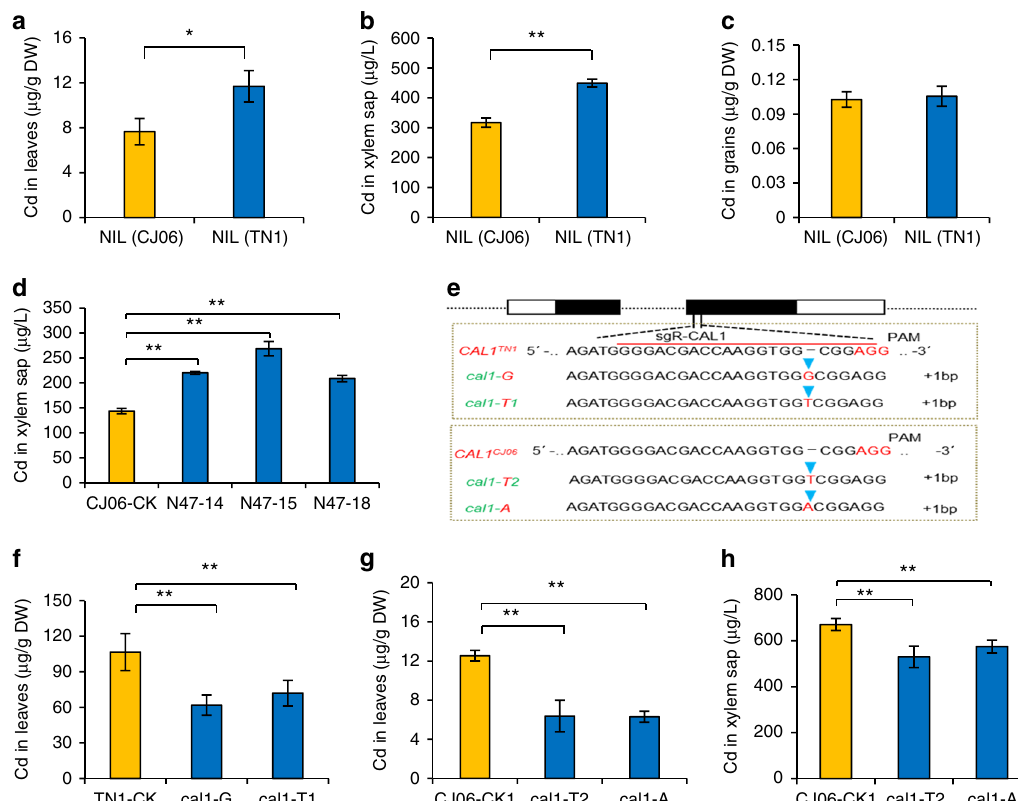
Fig. 2 CAL1 positively regulates Cd contents in rice leaf and xylem sap. Leaves and xylem sap were collected from 2 weeks old seedlings exposed to 10 µ M Cd for 7days, and grains was sampled from rice plants grown in Cd-contaminated paddy soil. a – c Cd levels in leaves ( a ), xylem sap ( b ) and grains ( c ) from NIL(TN1) and NIL(CJ06). d , e determination of Cd contents in xylem sap ( d ) of the CAL1 -complementation lines N47-14, N47-15, and N47-18, which simulate overexpression lines due to increased expression of CAL1 (Supplementary Fig. 3d) in CJ06 background. CJ06-CK represent transgene-negative controls. e Identi fi cation of cal1 mutants generated by CRISPR/Cas9. cal1-G and cal1-T1 represent mutants with single G or T insertion in CAL1 coding region, respectively, with TN1 background. cal1-T2 and cal1-A represent mutants with single T or A insertion in CAL1 coding region, respectively, with CJ06 background. f – h Cd contents in leaves ( f , g ) and xylem sap ( h ) of cal1 mutants. TN1-CK and CJ06-CK1 represent transgene-negative controls. Data are mean ± SD, n = 3 in ( a – c ), or 4 in ( d and f – h ). Signi fi cant differences were determined by Student ’ s t -test (* P < 0.05, ** P <